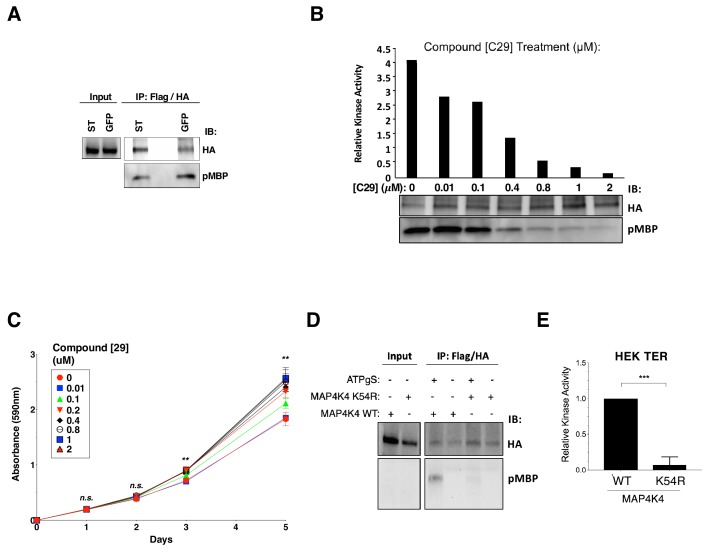
Changes in AI growth and proliferation with inhibition of MAP4K4 kinase activities.(A) In vitro kinase assay of tandem-affinity purified MAP4K4 (Flag/HA) from HEK TER cells expressing either ST or GFP was performed and MBP was used as a substrate. HA and phospho-MBP were detected by immunoblotting. (B) In vitro MAP4K4 kinase assay from HEK TER cells using increasing concentrations of the MAP4K4 inhibitor (Compound 29). MBP was used as a substrate and phosphorylation determined by phospho-MBP immunoblotting (bottom). Quantification of relative kinase activity (top). (C) Proliferation of HEK TER cells was measured after exposure to compound 29 at the indicated concentrations. The Student’s t-test was performed based on absorbance values measured between 0 uM and 1 uM at five days. (D) Representative immunoblot showing MAP4K4 in vitro kinase assay using tandem-affinity purified wild-type (WT) or kinase-dead mutant (K54R) MAP4K4. (E) Mean MAP4K4 activity of WT relative to kinase-dead mutant (K54R) assessed using in vitro kinase assay (student’s t-test: n.s. = not significant, **p<0.001, ***p<0.0001).